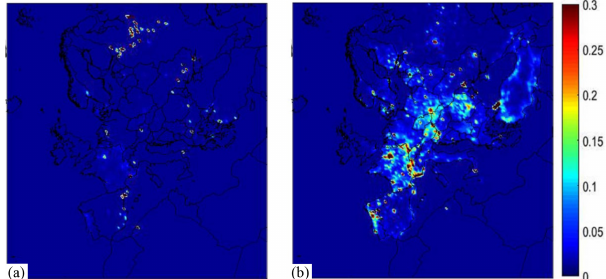
Figure 3. Spatial distribution of average biomass burning OA emis- sion rates (kgd − 1 km − 2 ) for the two simulation periods: (a) 1– 29 May 2008 and (b) 25 February–22 March